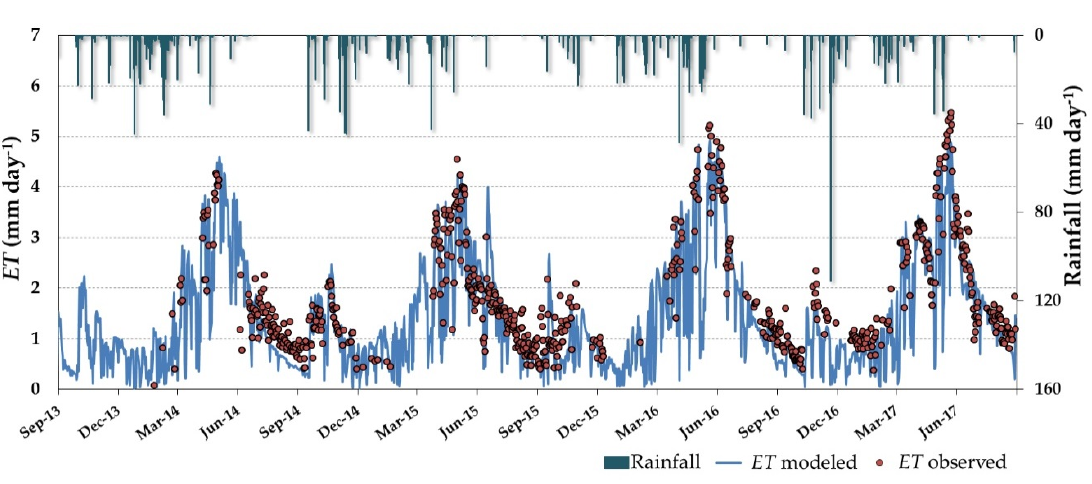
Figure 7. Daily evapotranspiration ( ET ) monitoring and water stress (ratio between evapotranspiration and reference evapotranspiration, ET/ET o ) over the dehesa ecosystem.